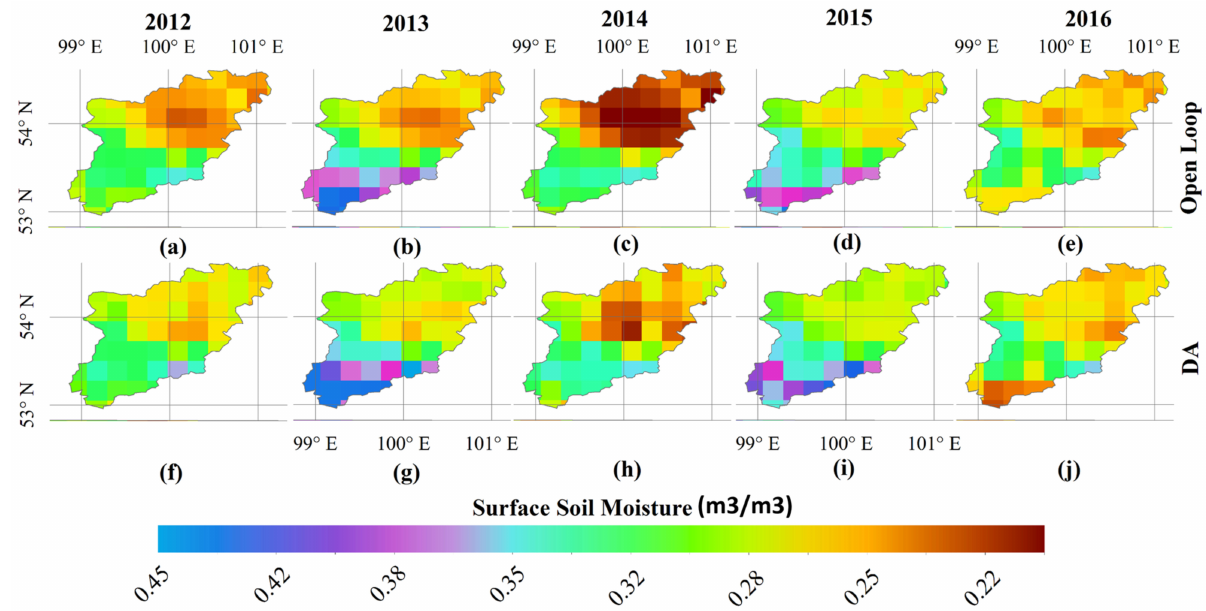
Figure 7. Represents spatial pattern of SM over Iya Basin during autumn season. Annual mean from open loop are shown in top row ( a – e ), from DA in bottom row ( f – j ).